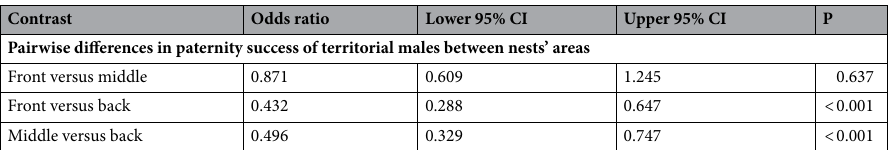
Table 5. Post-hoc tests of the analyses presented in Fig. 3 and Table 4. Pairwise differences of the paternity success of territorial males between the three areas of the nests. Note that the contrasts are expressed as odds ratios, and averaged across the levels of site. Such ratios and their 95% confidence intervals (CI) are back transformed from the log odds ratio scale. If the confidence interval of the odd ratio excludes 1, the difference is significant. P values are corrected for multiple testing using the Tukey